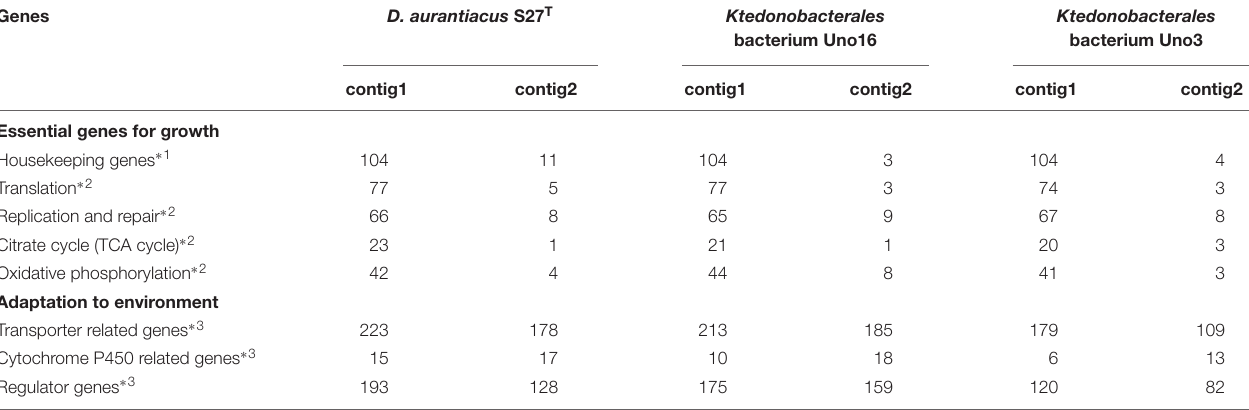
TABLE 3 | Comparisons of contig1 and contig2 in strains D. aurantiacus S27 T , Ktedonobacterales bacterium Uno16, and Ktedonobacterales bacterium